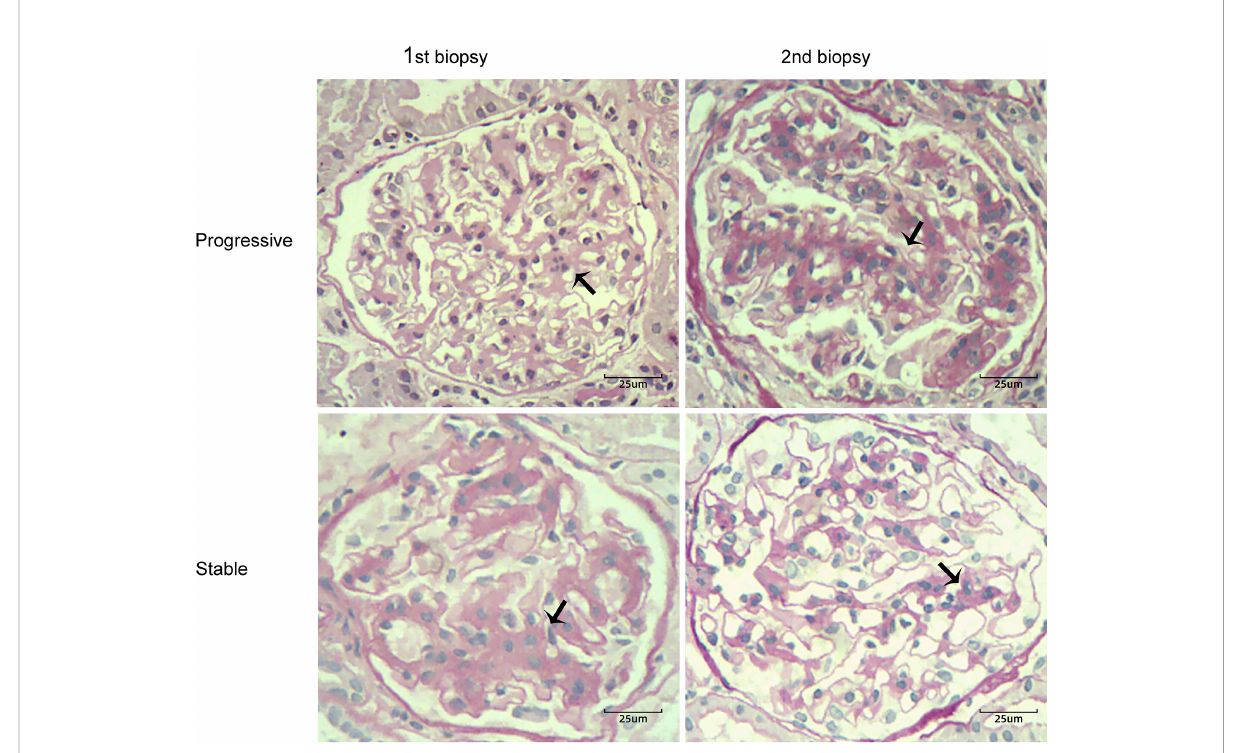
FIGURE 1 Two cases of IgA nephropathy with different degrees of mesangial proliferation (black arrow) between the fi rst and second renal biopsies (periodic acid-Schiff stain, ×400). Case 1 showed progression of mesangial hyperplasia in the second biopsy specimen; Case 2 showed regression of mesangial lesions in the second biopsy